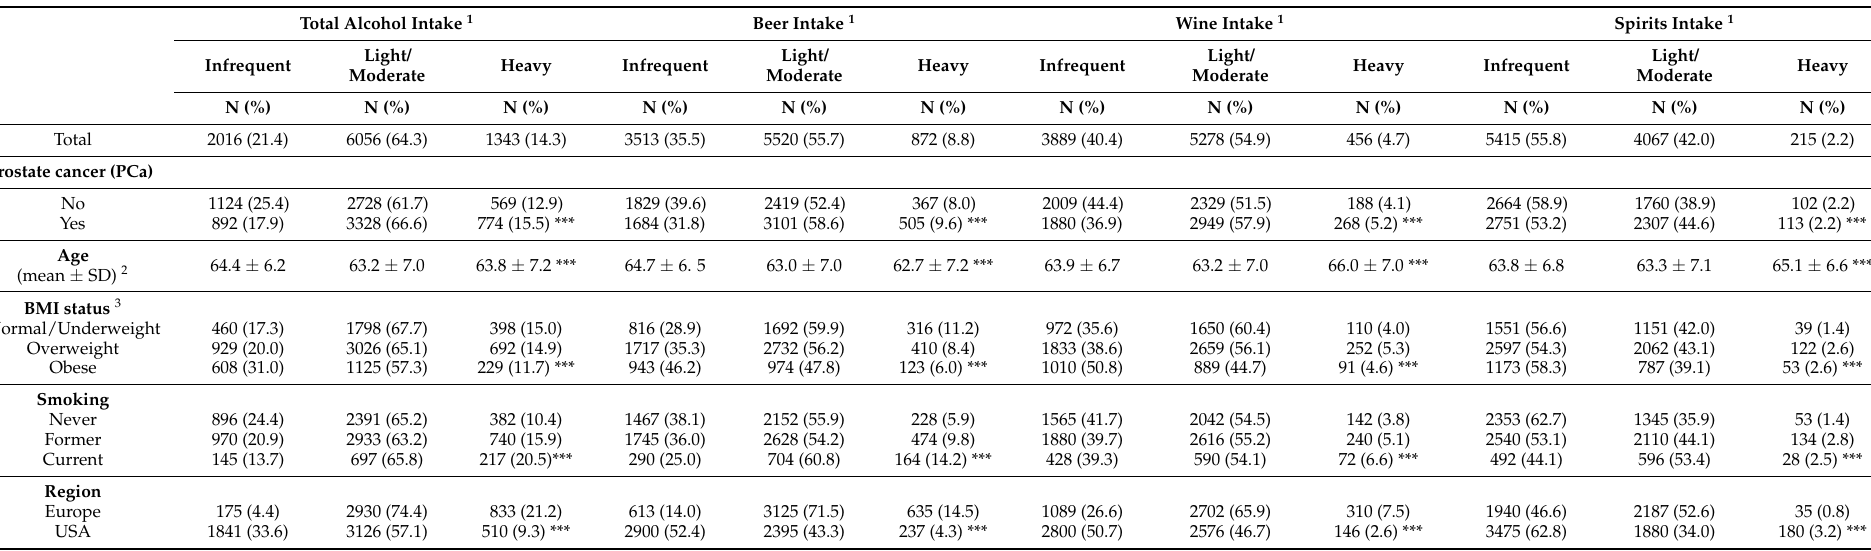
Table 1. Demographic and related characteristics by alcohol intake status for study participants (prostate cancer [PCa] patients + non-PCa men, N =